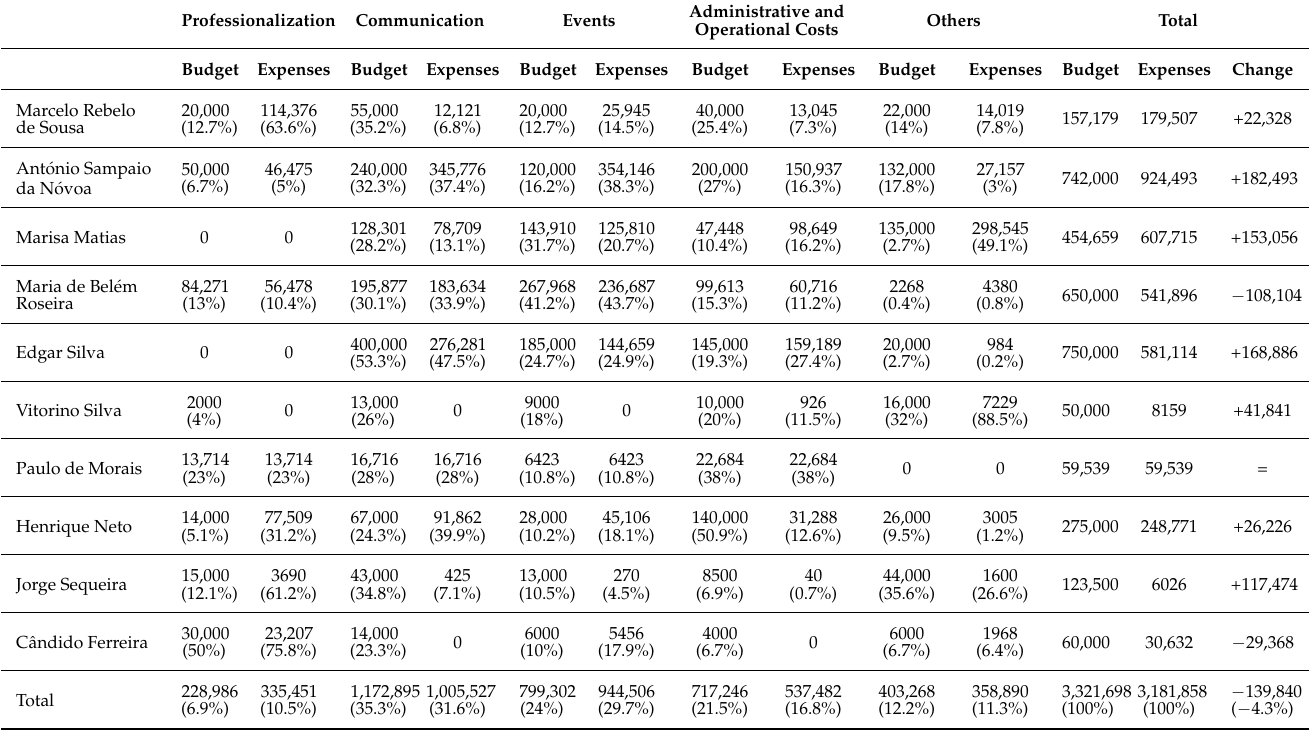
Table A2. Planned investment and actual expenses in the 2016 Presidential election